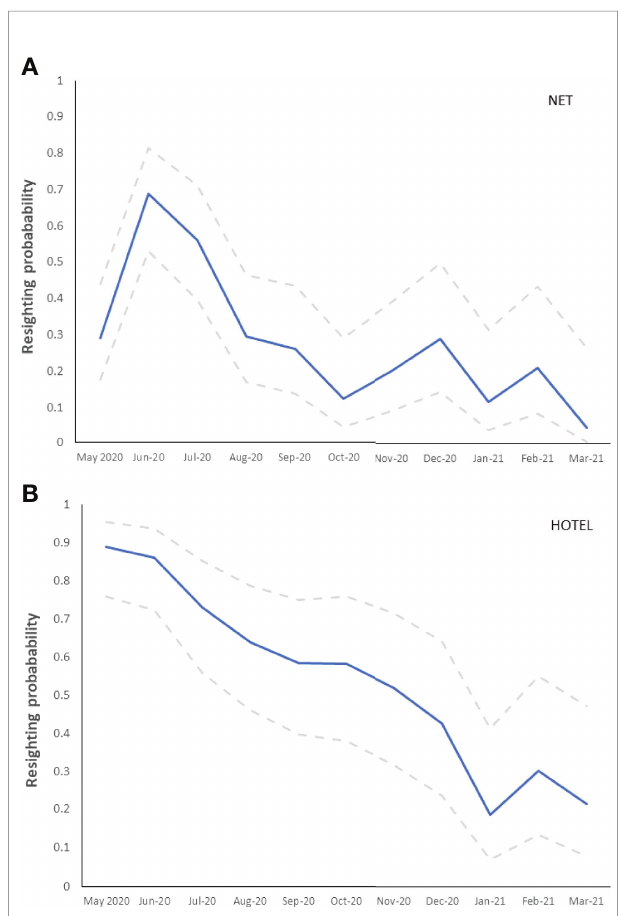
FIGURE 4 | Variability in resighting probability based on mark-resight data of captive-bred tagged seahorses from May 2020 – March 2021 between (A) protective swimming net and (B) seahorse hotels. Dashed lines indicate the 95% upper and lower con fi dence